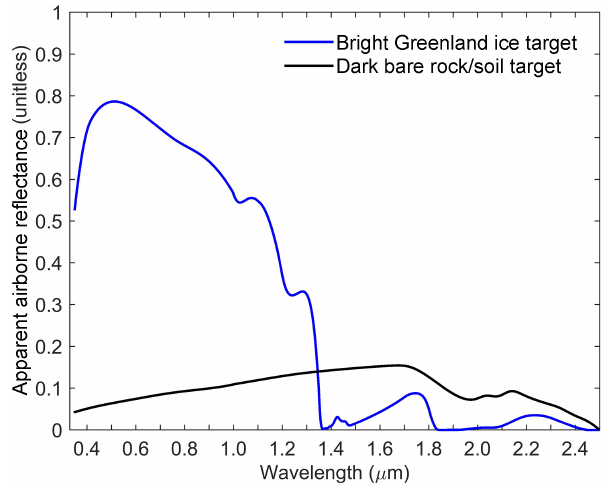
Figure 9. Apparent reflectance spectra for bright and dark absolute in-flight targets measured with the nadir-viewing spectrometer.